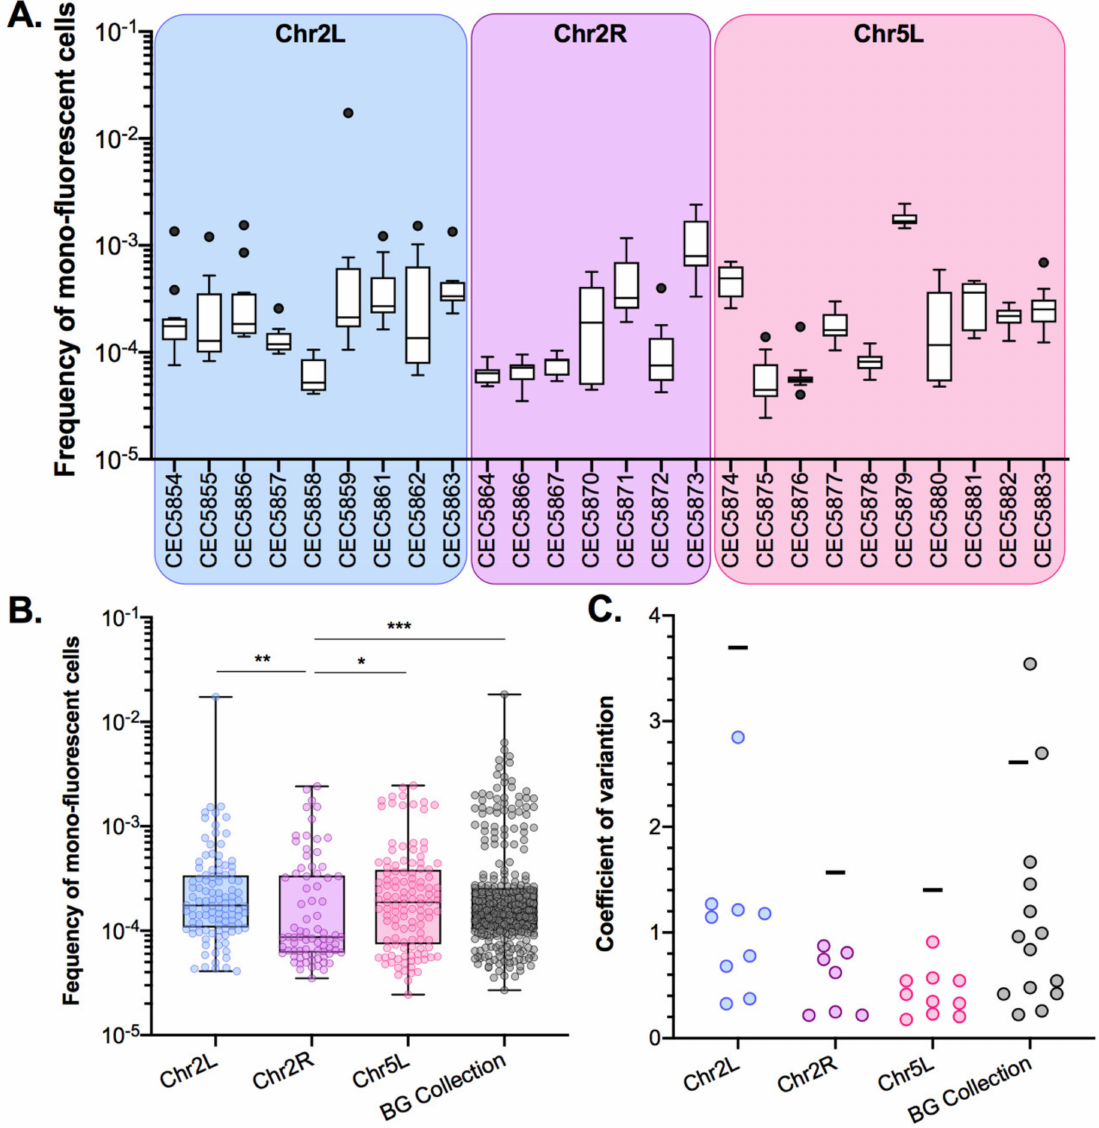
Figure 5. Inter-strain heterogeneity of basal LOH frequency. ( A ). Median frequencies of mono- fluorescence in YPD, basal LOH frequencies, represented as box plots and whiskers (Tukey) were assessed by fluctuation analysis ( n = 12) for genomic loci: Chr2L (9 strains), Chr2R (7 strains), and Chr5L (10 strains). ( B ). Pooled frequency of mono-fluorescence for the three loci illustrated in the top panel (Chr2L, Chr2R, and Chr5L) and for the 14 strains and loci in the Blue-Green (BG) collection (Figure 2). Overall median frequencies were compared using the Mann–Whitney test, significant differences are shown on the graph * p < 0.05, ** p < 0.001 and *** p < 0.0001). ( C ). Variation of LOH frequencies is represented by the coefficient of variation, where circles represent a given strain while horizontal lines depict the variation between